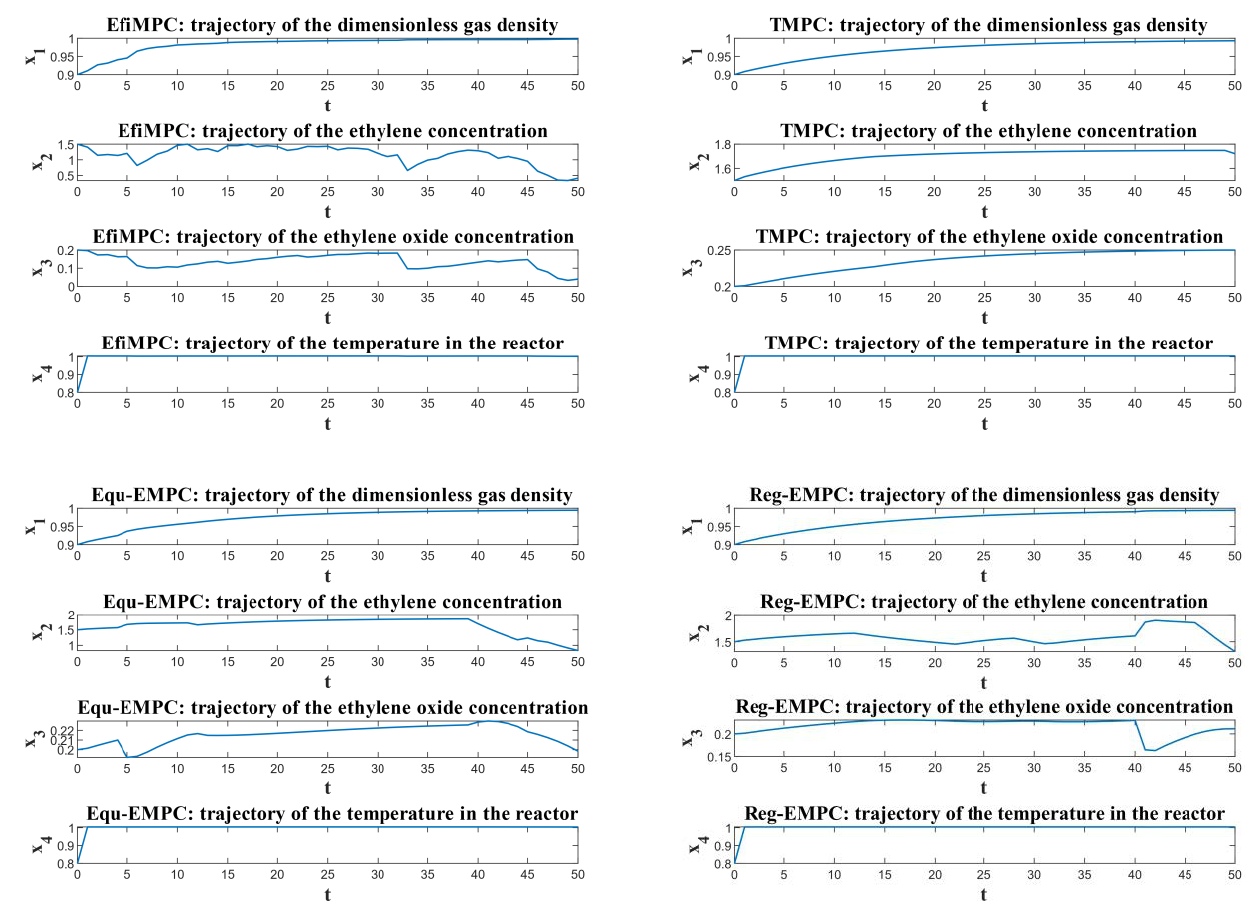
Figure 7. The state trajectories of the comparative control strategies.